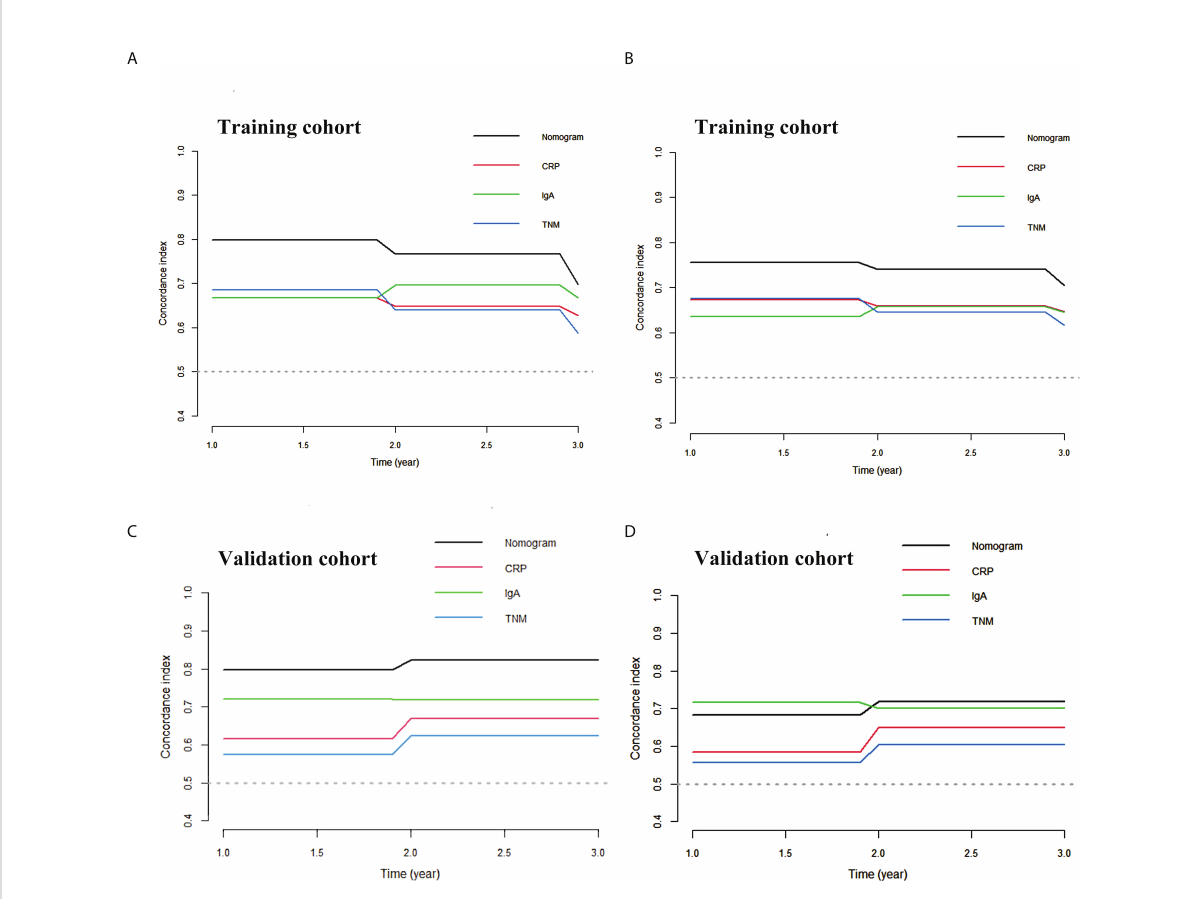
FIGURE 4 The C-index curve of the nomogram. (A) The C-index curve under the time distribution of 3 years to predict OS in training cohort. (B) The internal veri fi cation by Bootstrap algorithm of 3 years to predict OS in training cohort. (C) The C-index curve under the time distribution of 3 years to predict OS in validation cohort. (D) The internal veri fi cation by Bootstrap algorithm of 3 years to predict OS in validation cohort. OS, overall